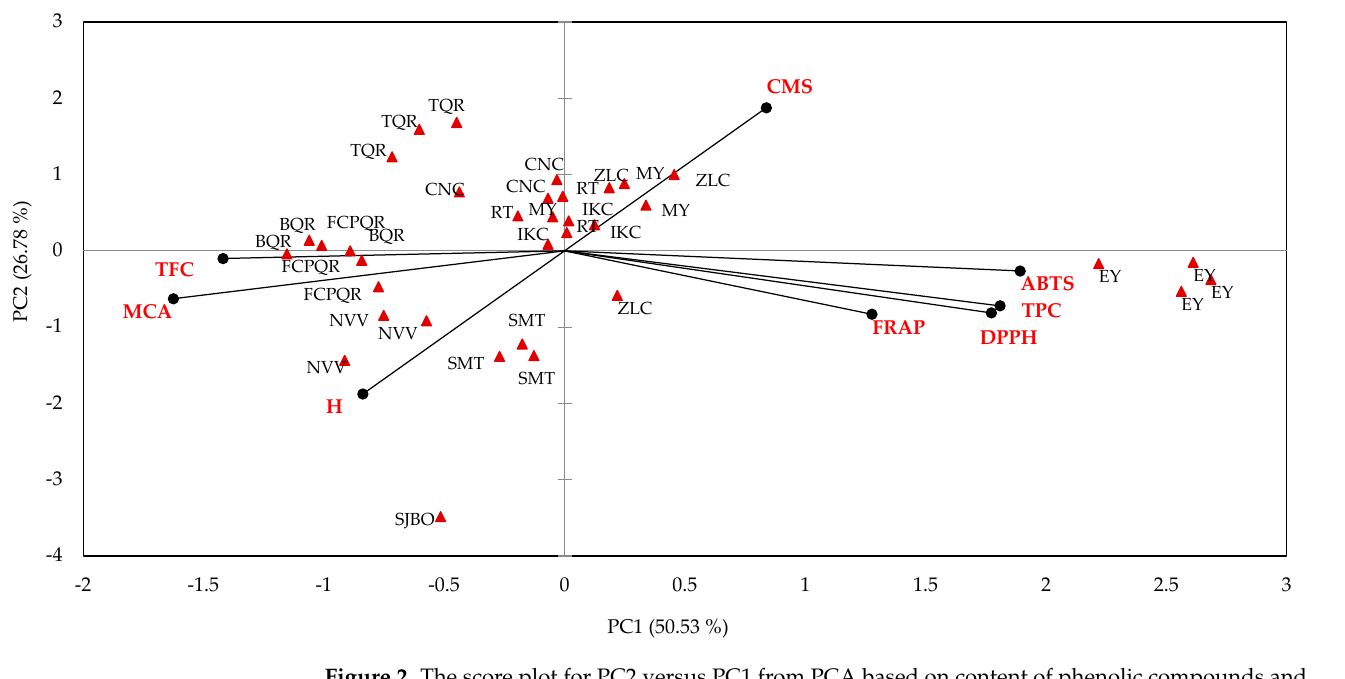
Figure 2. The score plot for PC2 versus PC1 from PCA based on content of phenolic compounds and in vitro assays of bioactivity properties for propolis classification following its geographic location. Italic codes indicate samples from different locations. Bold codes indicate determined variables. TPC = Total phenolic content. F = Flavonoids. DPPH = DPPH free radical (hydrophobic) scavenging, ABTS = ABTS free radical (hydrophilic) scavenging, MCA = Metal chelating activity, FRAP = Ferric